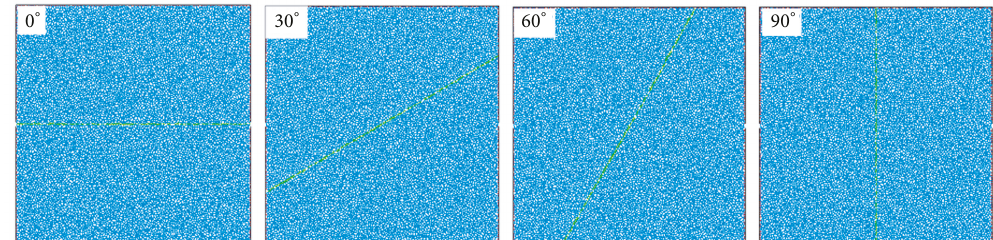
Figure 10: Numerical models with a single bedding plane at various angles of inclination.